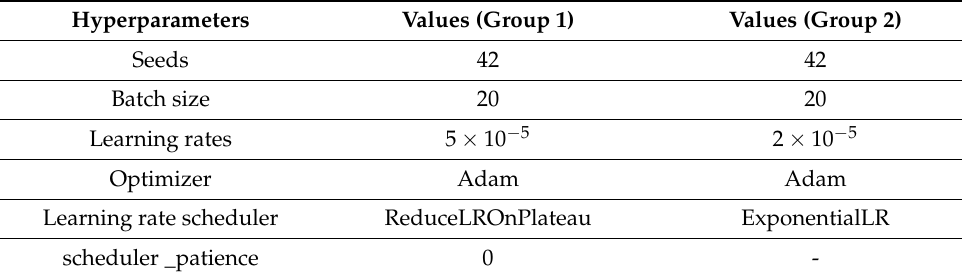
Table 4. Hyperparameters used in InfoNCE loss training stage.